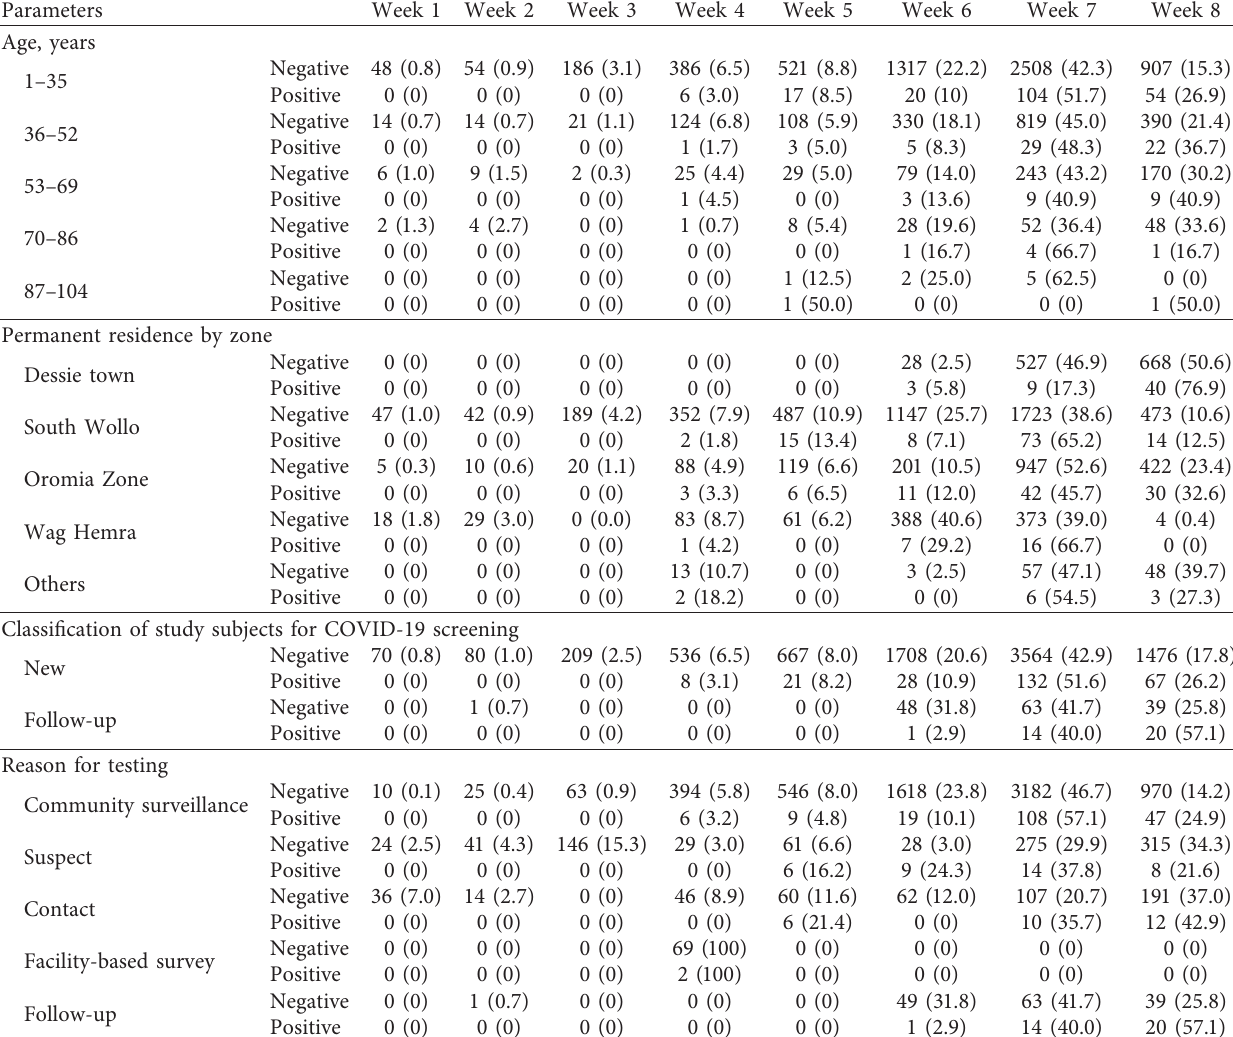
Table 3: Trend of COVID-19 infection in the northeastern region of Ethiopia from July 01, 2020, to August 31, 2020, by different variables across each week ( N �